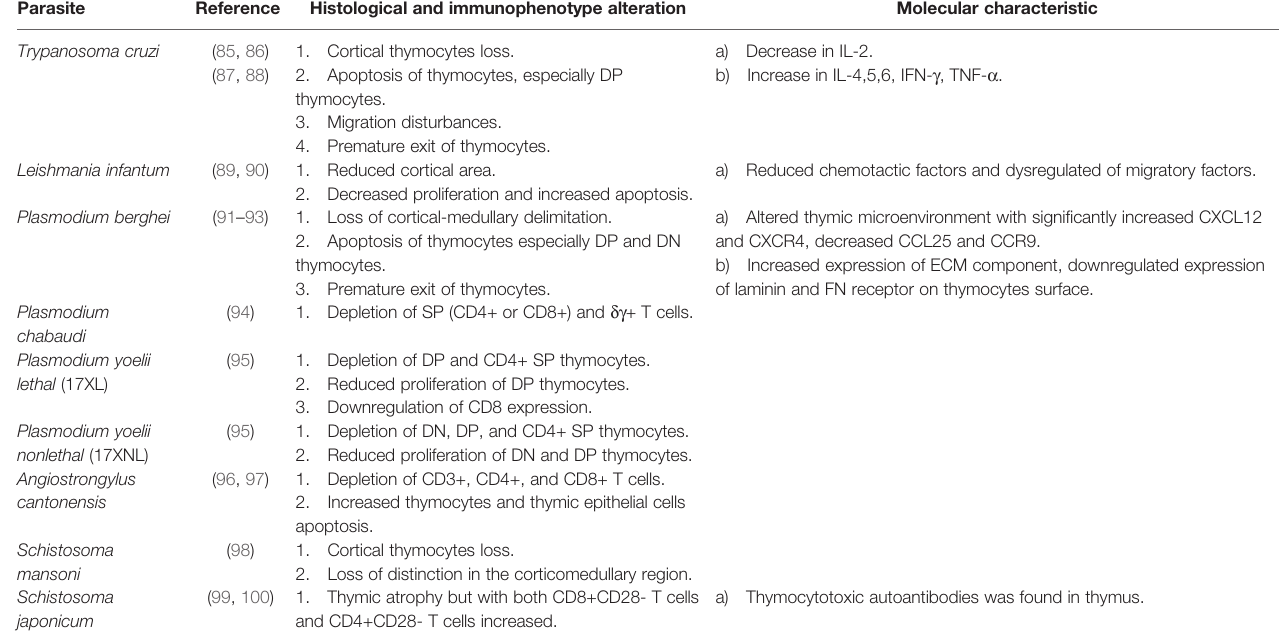
TABLE 3 | Alterations and characteristics of parasite-induced thymic